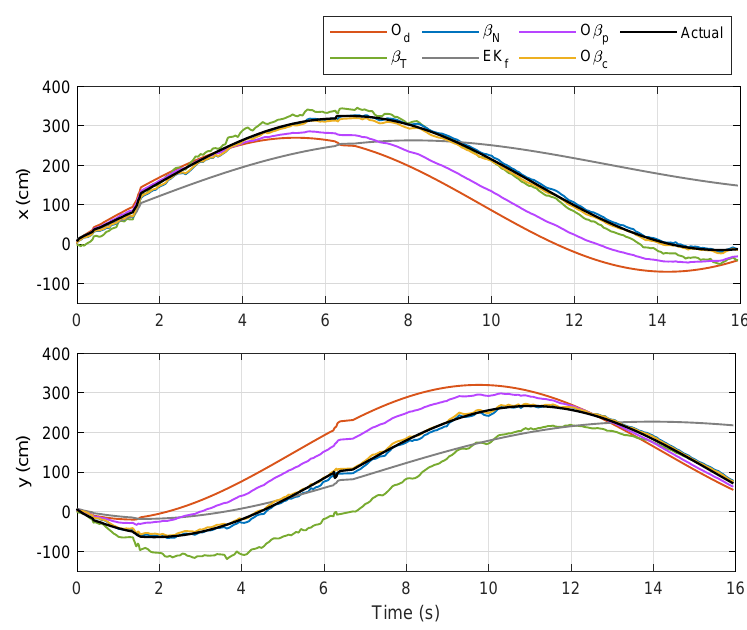
Figure 20. Localization of Node M in x - and y -directions in Trajectory 4.